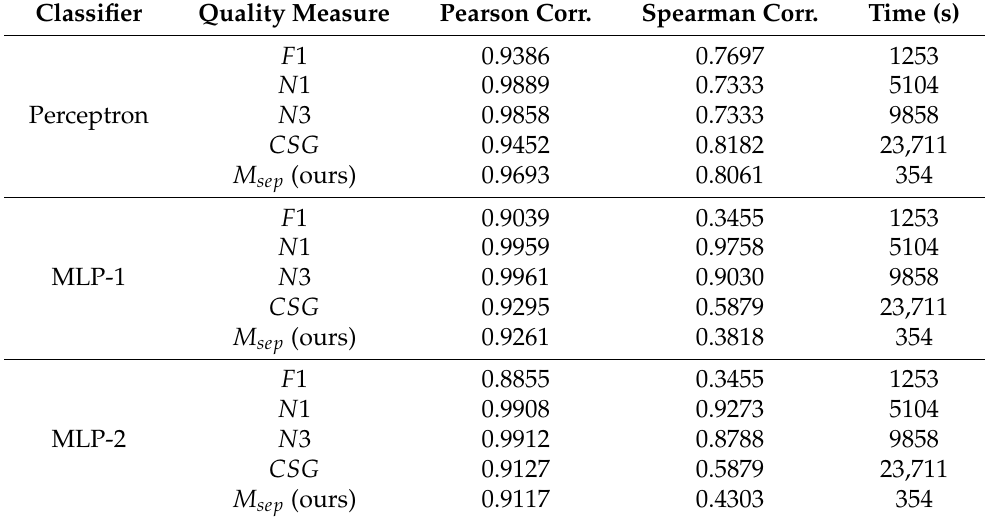
Table 2. The absolute Pearson and Spearman rank correlation between the quality measures and the accuracy of three classifiers on the ten image datasets (MNIST, CIFAR10, notMNIST, Linnaeus, STL10, SVHN, ImageNet-1, ImageNet-2, ImageNet-3, and ImageNet-4). The computation time of our method M sep is the